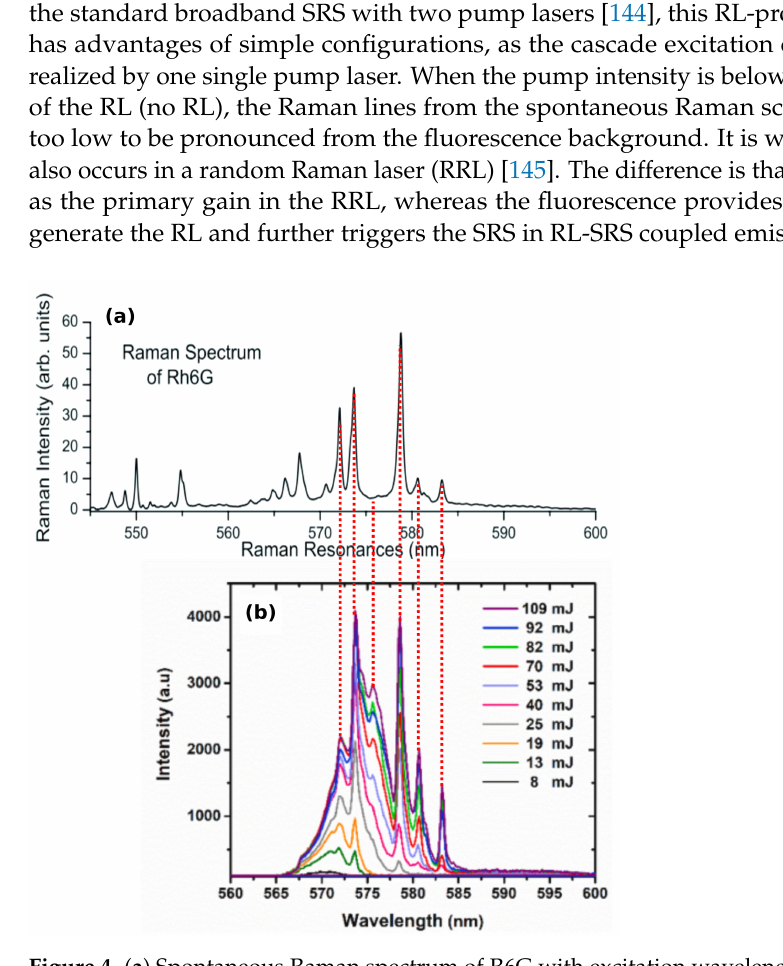
Figure 4. ( a ) Spontaneous Raman spectrum of R6G with excitation wavelength of 532 nm. Adapted from Ref. [141] with permission from IOP Publishing. ( b ) Stimulated Raman scattering signals generated from an RL medium consisting of ZnO nanospheres and R6G methanol colloid in flask, pumped by a laser with wavelength of 532 nm, pulse duration of 7 ns and pump spot of 3 mm. Adapted from Ref. [140] with permission from